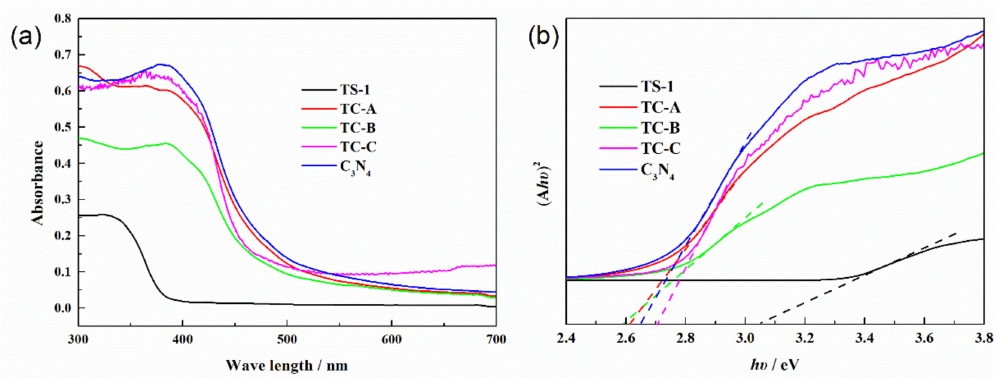
Figure 2. UV-Vis DRS spectra ( a ) and Tauc plots ( b ) of all the